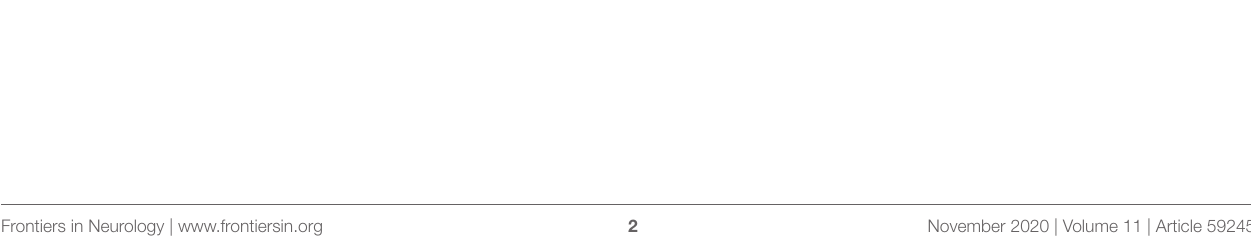
Frontiers in Neurology | www.frontiersin.org